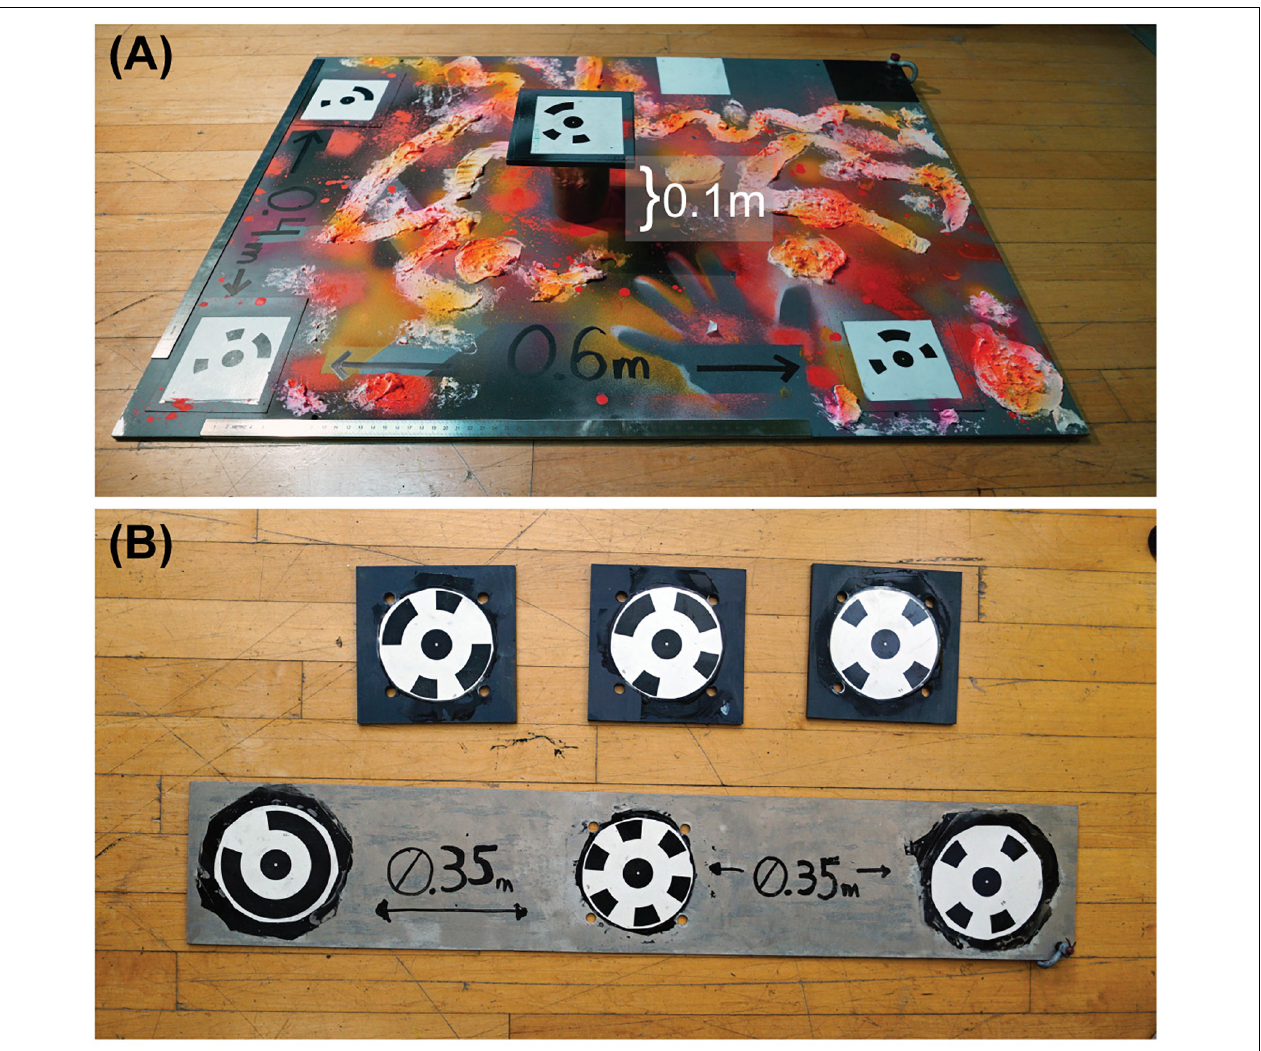
FIGURE 4 | Machined scale bars and targets for accuracy assessment during field operations: (A) submersible camera calibration plate including precisely positioned circular encoded targets in three dimensions, painted with texture to assist Structure-from-Motion (SfM) photogrammetry reconstruction of the plate and with black and white squares for exposure and color balance adjustment; (B) individual circular encoded targets and a linear scale bar for mounting precisely to the Surface Elevation Table (SET)